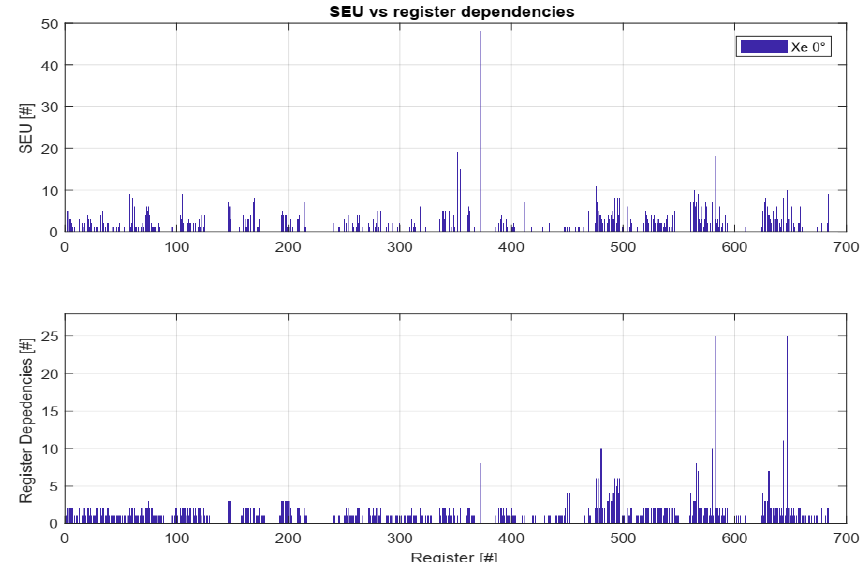
Figure 19. Accumulated SEUs and register dependencies for the monitored functional registers on DUT 1 with Xe 0°.